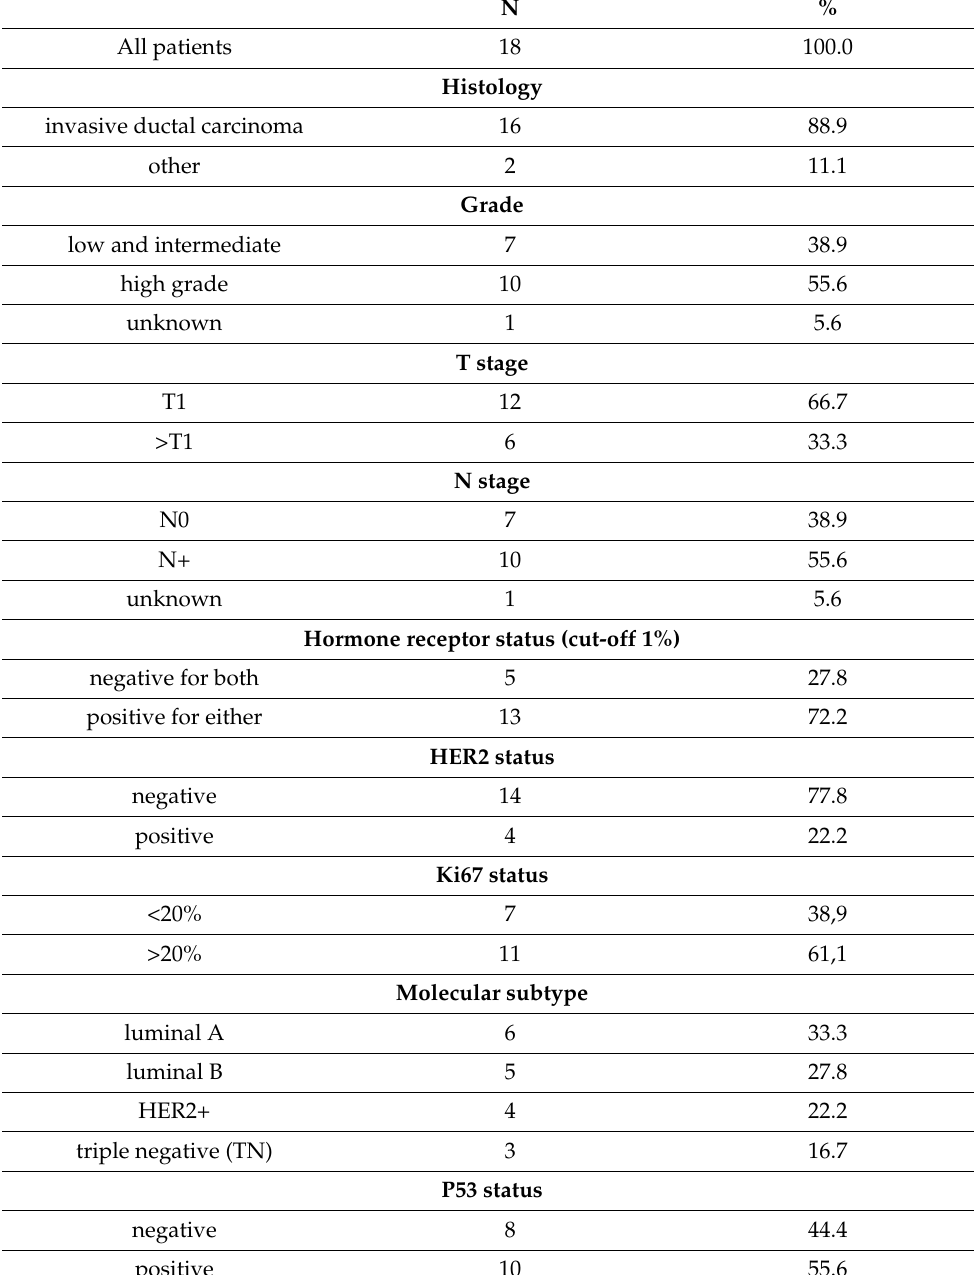
Table 1. Patient’s